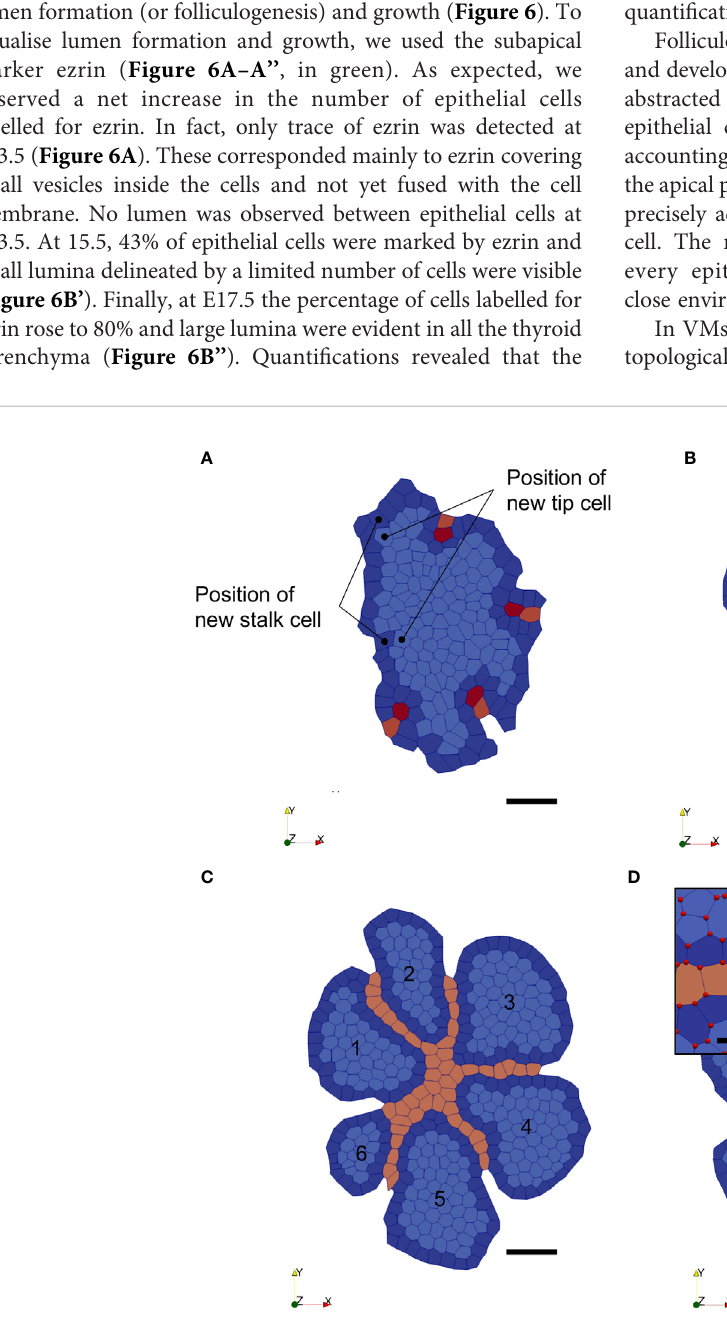
FIGURE 5 | Snapshots of the VM simulation of thyroid epithelial sheet growth and endothelial invasion within the epithelial sheet. (A) Initial con fi guration of the thyroid VM (t = 0h). Epithelial cells are labelled in blue (dark at the periphery and light in the centre), endothelial tip cells are in red, and endothelial stalk cells in orange. Position of new stalk and tip cells are indicated. (B) Con fi guration at simulation time t = 10h with endothelial boundaries (Endo-BC) created for the most peripheral stalk cells. The added tip cells migrated towards the gradient, forming new vessels (red arrows). Fragmented epithelial structures are numbered (from 1 to 6). (C) Con fi guration at simulation time t = 18h. Epithelial cells continued to proliferate and grow outwardly in each bud-like structure separated by the endothelial vessels (orange). (D) Con fi guration at simulation time t = 24h. Epithelial cells continued to grow, leading to the expansion of the bud-like structures. The «virtual» endothelial vessels induced by the Endo-BC are now visible between the growing epithelial buds. The close-up view shows the vertices represented as red dots. Fixed vertices are indicated by the two large red